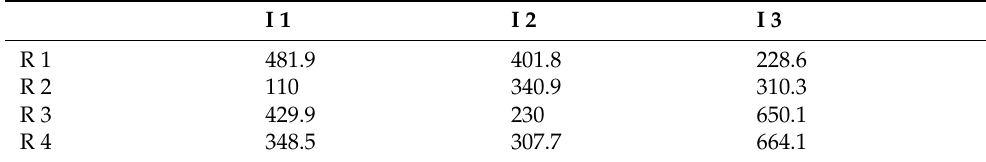
Table A6. Distance between manufacturing I plant and recycling center R (km).